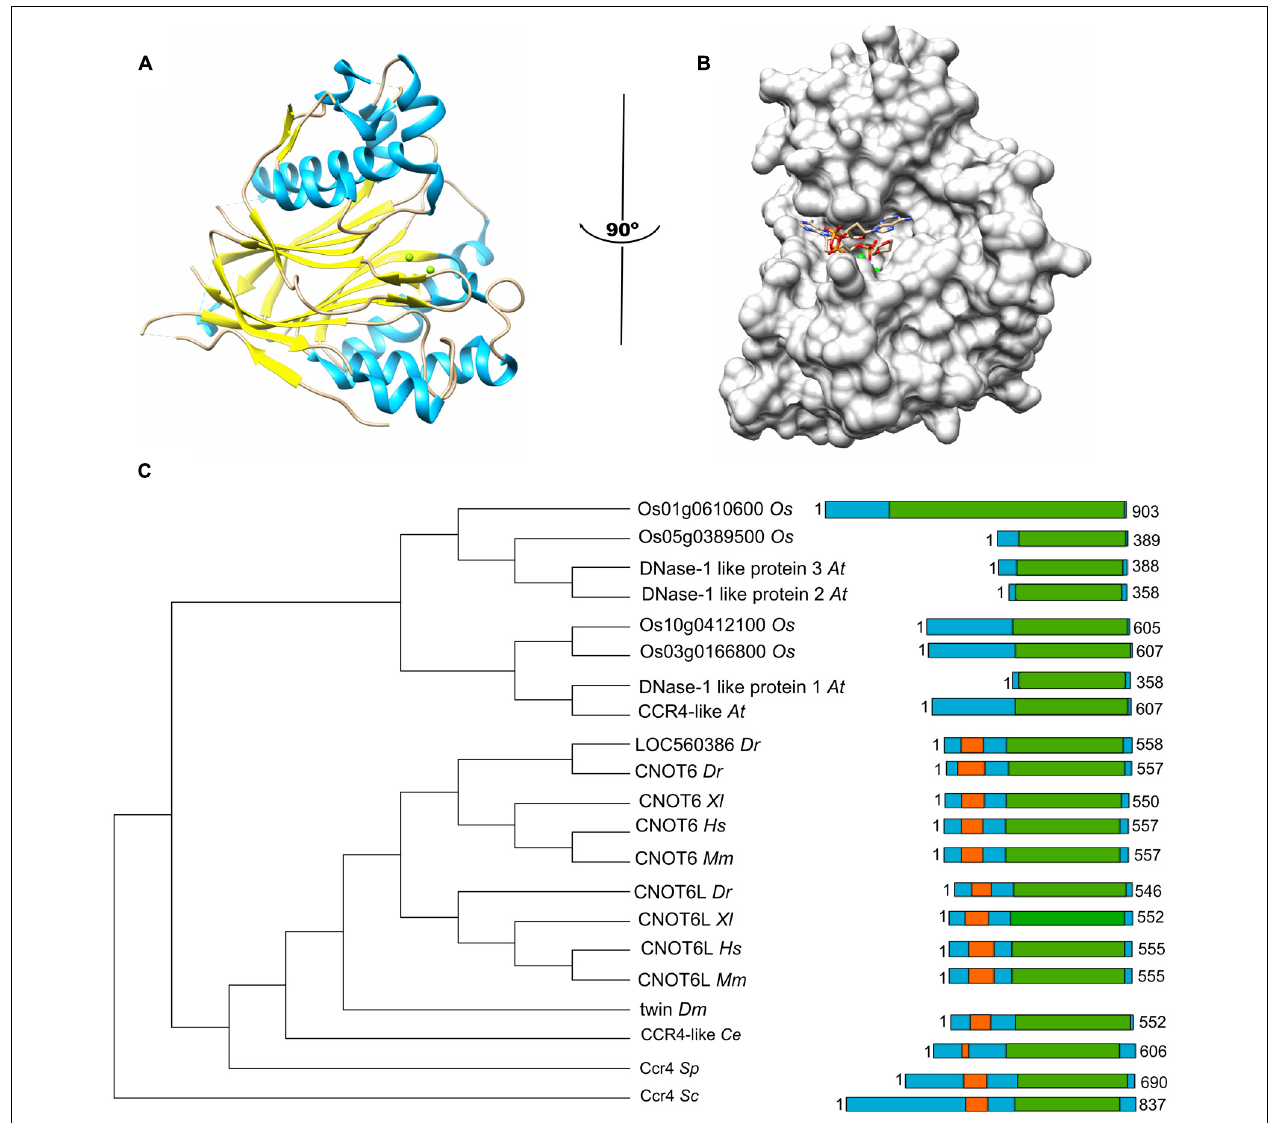
eukaryotic kingdom. Sequence analysis was carried out using Basic local alignment search tool (BLAST) in combination with the Reference protein database. Only homologs with > 75% sequence coverage as compared to Saccharomyces cerevisiae ( Sc ) Ccr4 were selected from the following species: Schizosaccharomyces pombe ( Sp ), Caenorhabditis elegans ( Ce ), Drosophila melanogaster ( Dm ), Danio rerio ( Dr ), Xenopus laevis ( Xl ), Mus musculus ( Mm ), Homo sapiens ( Hs ), Arabidopsis thaliana (At) , and Oryza sativa (Os) . The EEP domain is indicated in green; the leucine-rich repeat domain is highlighted in